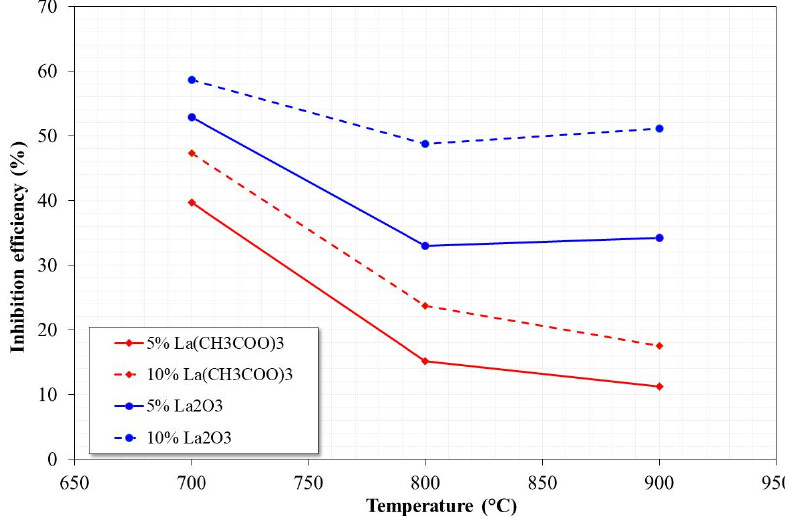
Figure 6. Inhibition efficiency of La compounds after 100 h of testing in NaVO 3 at 700, 800, and 900 °C.